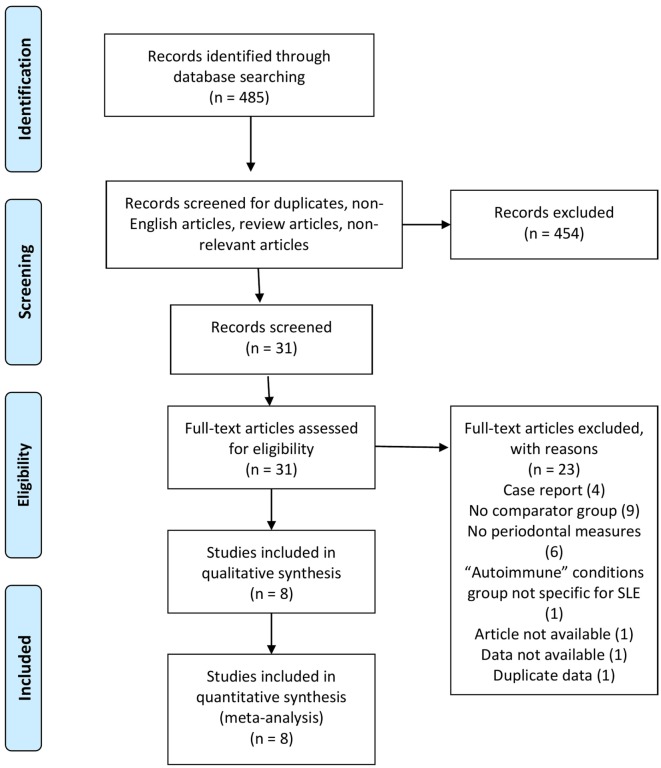
PRISMA flow diagram showing results of search strategy.